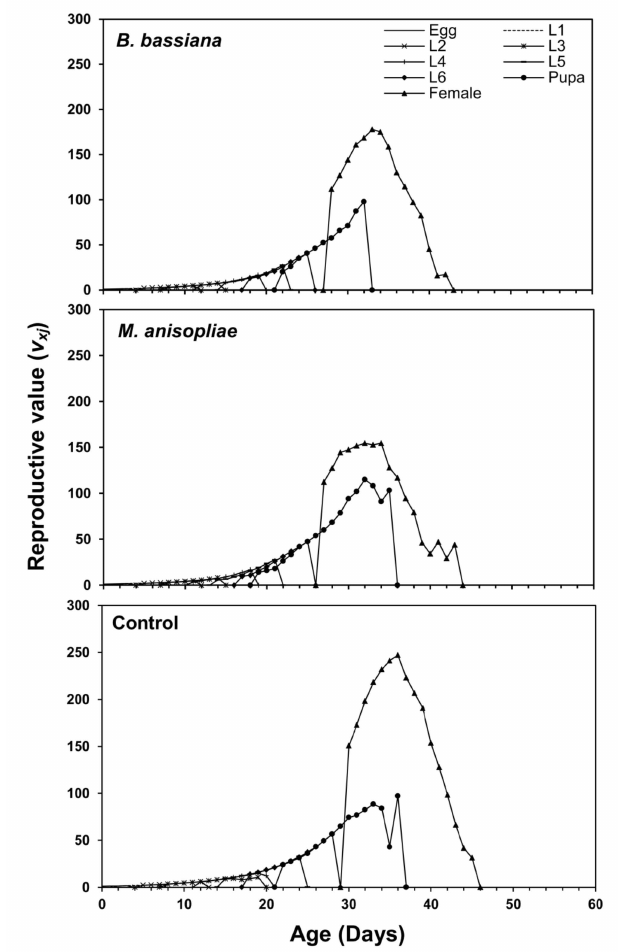
Figure 5. Age-stage-specific reproductive value ( v xj ) of Spodoptera frugiperda fed on endophytic colonized and non-colonized